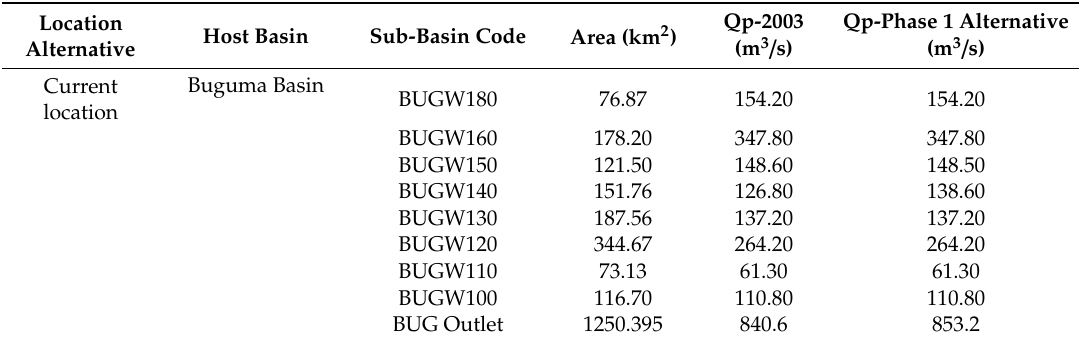
Table 8. Modelled result of peak flow responses to Current Project Alternative in Port-Harcourt Basin.; BUG Buguma Basin; W = watershed; Qp = Peak discharge; Qp-2003 = Peak discharge based on year 2003 land use/land cover (LULC) condition; Qp-Phase 1 Alternative = Peak discharge based on Phase 1 alternative LULC condition.